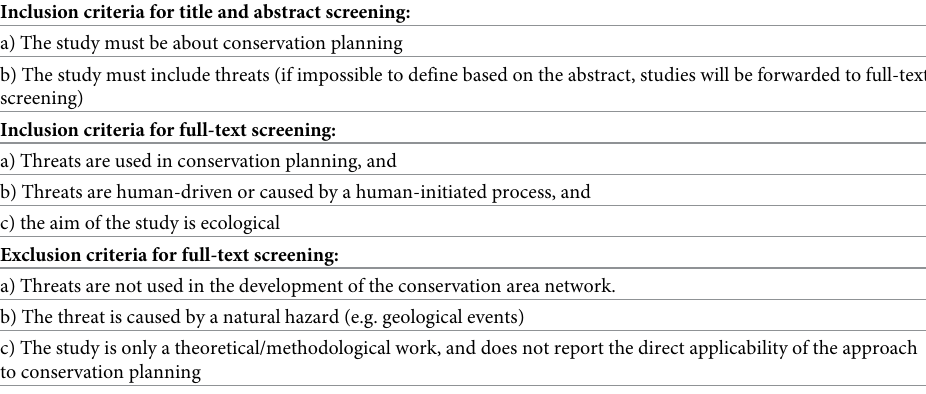
Table 4. Inclusion and exclusion criteria for